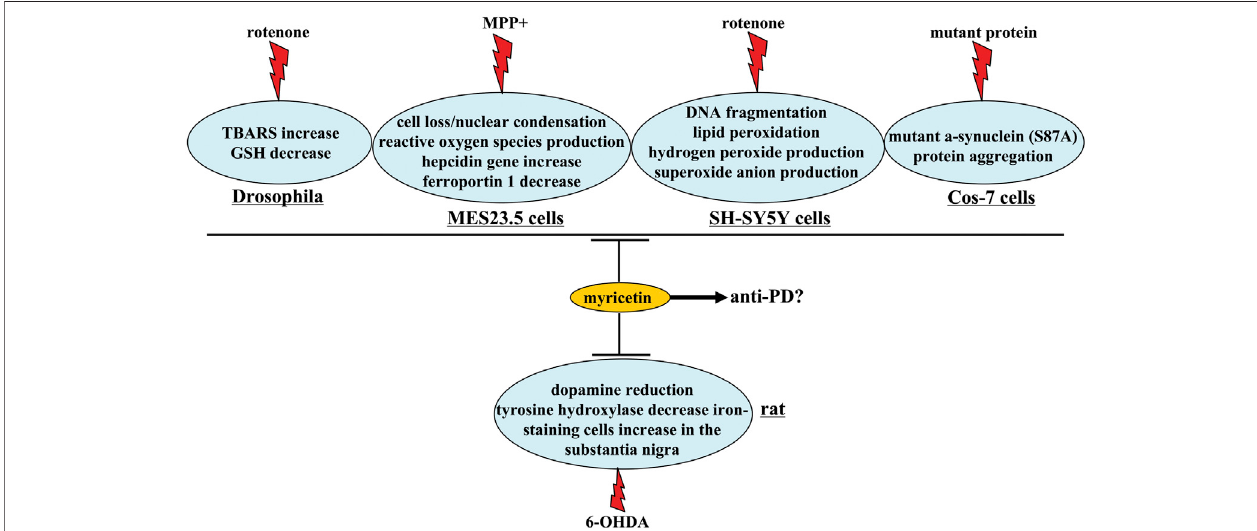
FIGURE 4 | Neuroprotective effects and possible mechanisms of myricetin in Parkinson ’ s disease-associated models. Myricetin produces anti-PD ’ s effects via suppressing 6-OHDA-induced decrease in dopamine contents and tyrosine hydroxylase expression and increase in iron-staining cells in the substantia nigra. Myricetin also has protective effects in Drosophila , MES23.5 cells, SH-SY5Y cells, and Cos-7 cells, as indicated by the concrete descriptions in this fi gure. Whether these effects could mediate the anti-PD effect of myricetin remain unclear.